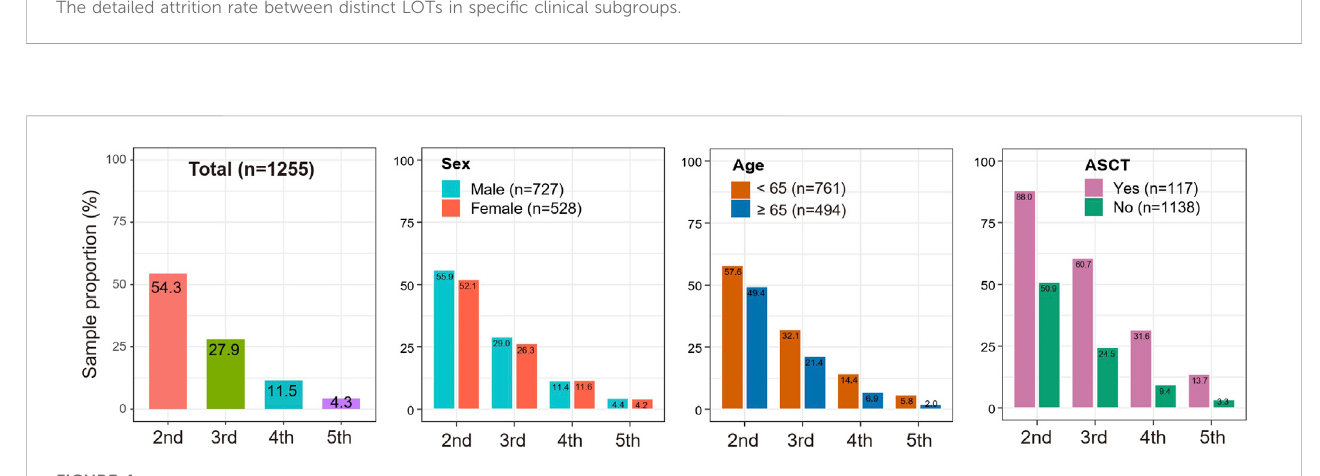
FIGURE 4 Proportions of MM patients reaching subsequent LOTs under distinct clinical